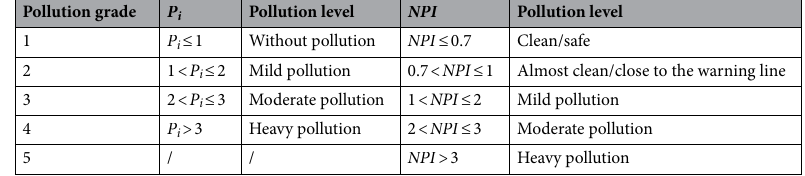
Table 2. Classification standard for single factor pollution index and Nemerow pollution index.